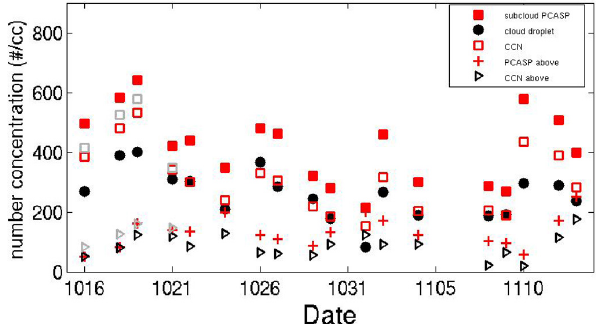
Fig. 13. Average subcloud aerosol (red solid square), above-cloud aerosol (red cross), sublcloud 0.2% CCN (open red square), above- cloud 0.2% CCN (black triangle), and cloud droplet (black dot) number concentrations on all flight days. The average 0.5% CCN values for the first four flight days are marked as gray symbols.